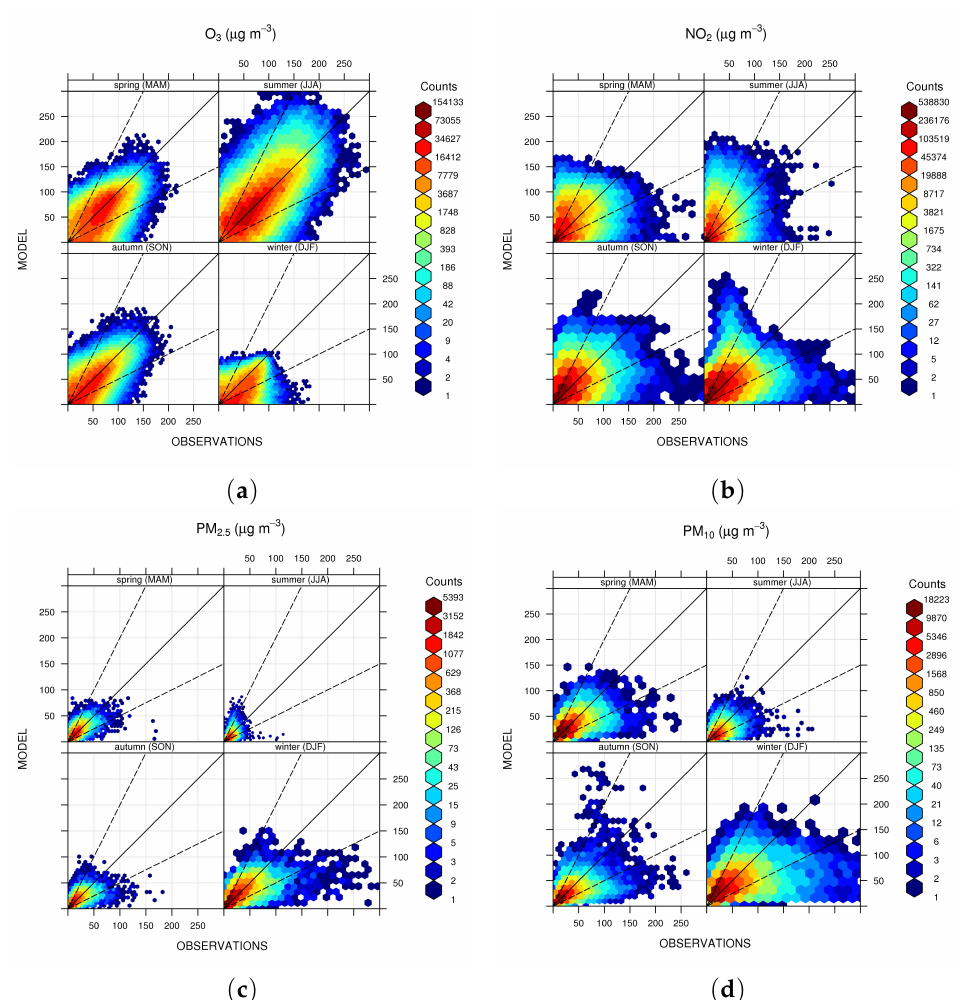
Figure 7. Scatter plots for hourly O 3 ( a ) and NO 2 ( b ) concentration and daily PM 2.5 ( c ) and PM 10 ( d ) concentration. The point refers to the samples having the concentration value ( µ g m − 3 ) reported on the axis. Such calculations was done on seasonal basis: upper-left spring, upper-right summer, down-left autumn and down-right